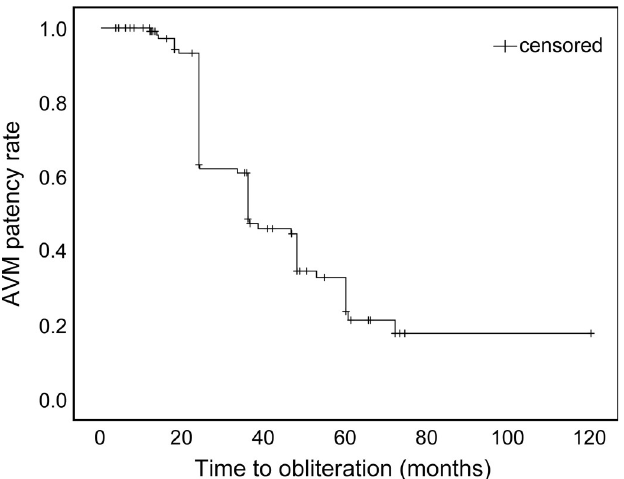
Fig 3. Time to obliteration after CyberKnife radiosurgery–Kaplan-Meier curve. Kaplan-Meier curve of the time (in months) to the obliteration of arteriovenous malformations (AVMs) in patients treated via CyberKnife radiosurgery. Obliteration is observed between 24 and 48 months after treatment in the majority of